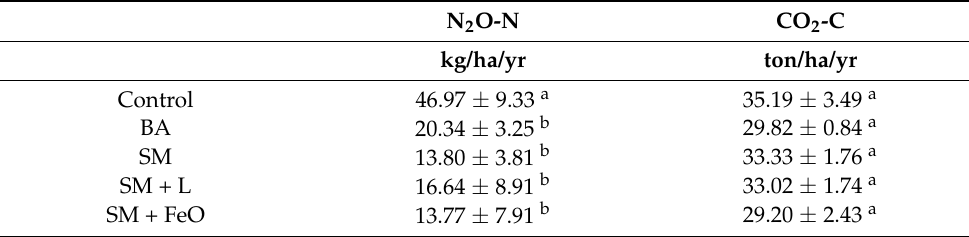
Table 6. Cumulative N 2 O-N and CO 2 -C emission amounts based on a monthly measured gas emis- sion flux.